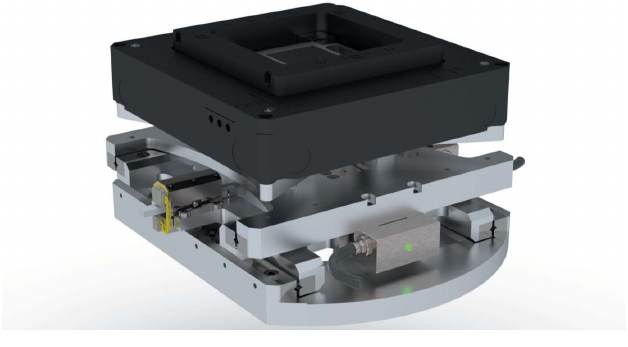
Figure 9 The sample coarse-positioning assembly, in gray in the figure, carries a high-precision three-axis scanner from nPoint, in black.